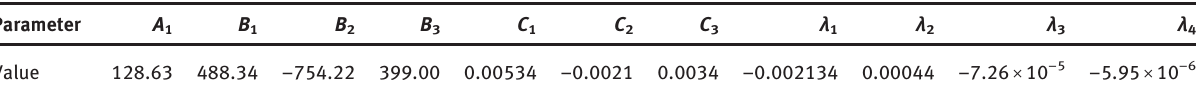
Table 3: Parameters for the modified Johnson – Cook model. Parameter